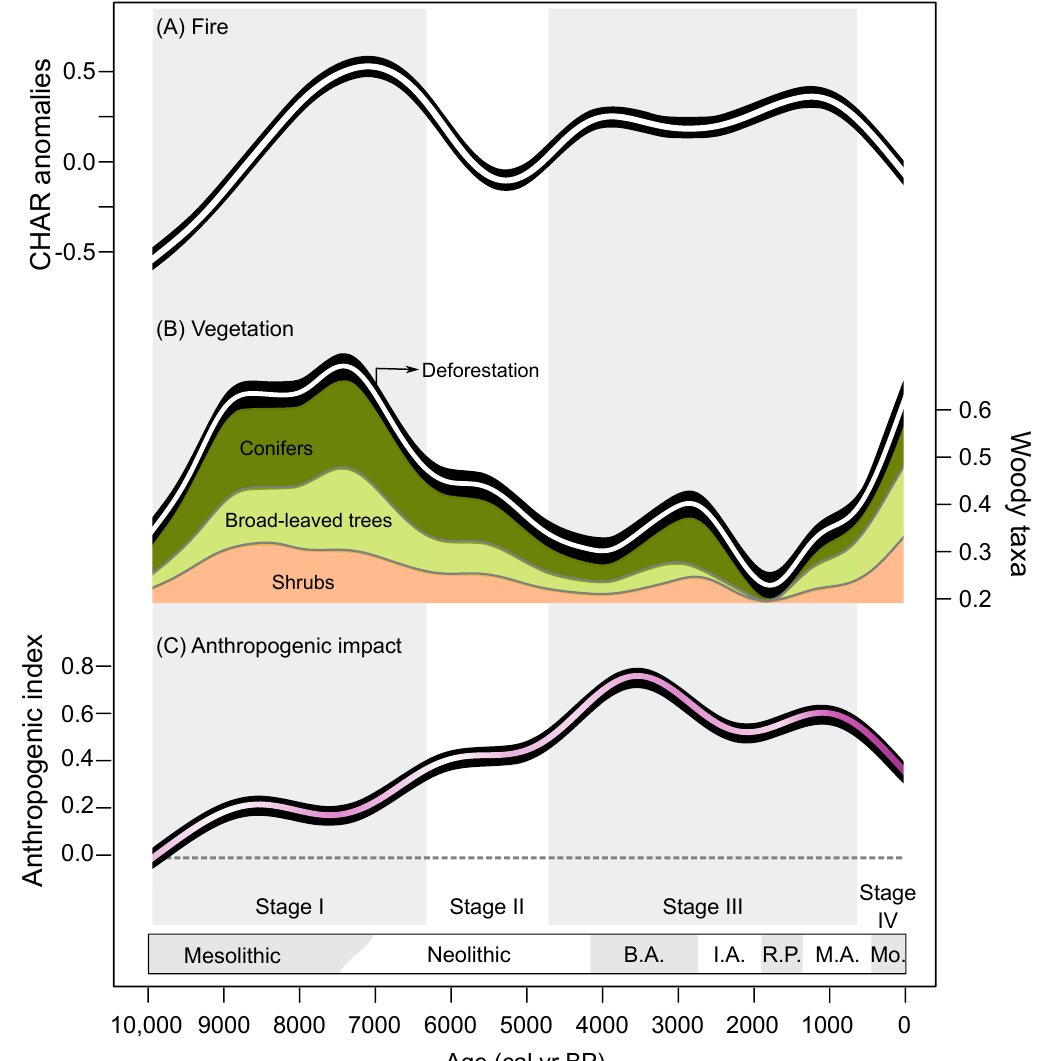
Figure 6. Holocene trends in fire, vegetation and anthropogenic impact in the Southern Mediterranean. ( A ) Regional biomass burning as estimated by a GAM applied to the charcoal data from the sub-region ( B ) Vegetation openness inferred from woody-to-herbaceous pollen taxa. The relative proportion of conifers, broad-leaved trees and shrubs is shown. ( C ) Anthropogenic index as a function of time. The pink shading represents the total anthropogenic index-to-ruderal taxa ratio. The arrow shows the onset of pronounced deforestation depicted in Figure 7. In all cases, the black shading depicts 95% confidence intervals for the estimated